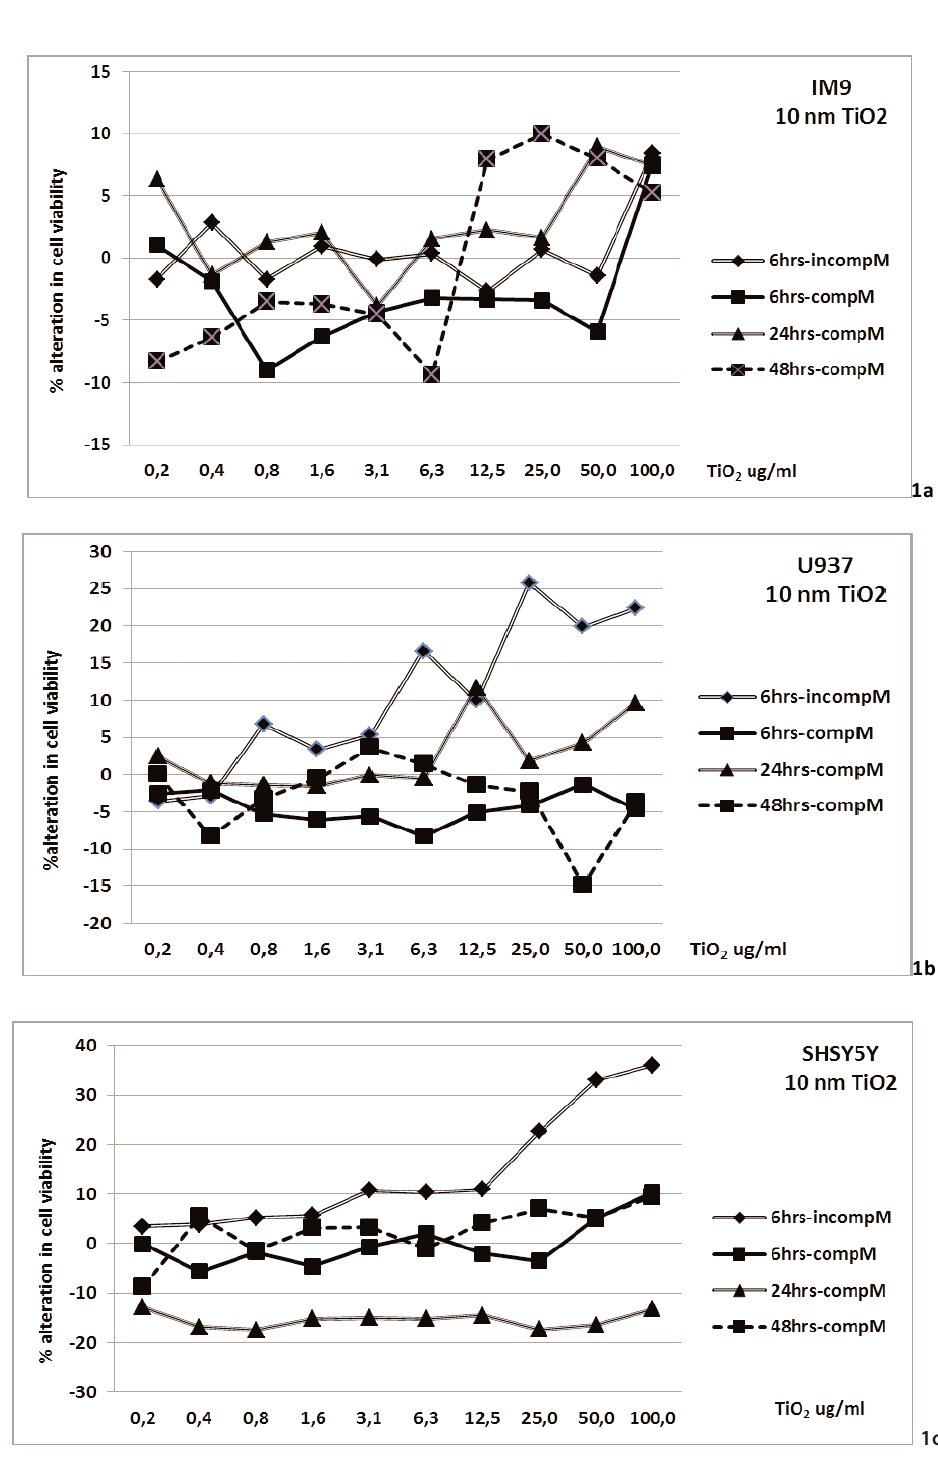
Figure 1.: % alteration in cell viability of IM9 (a), U937 (b) and SHSY5Y (c) cells after exposure to 10 nm TiO